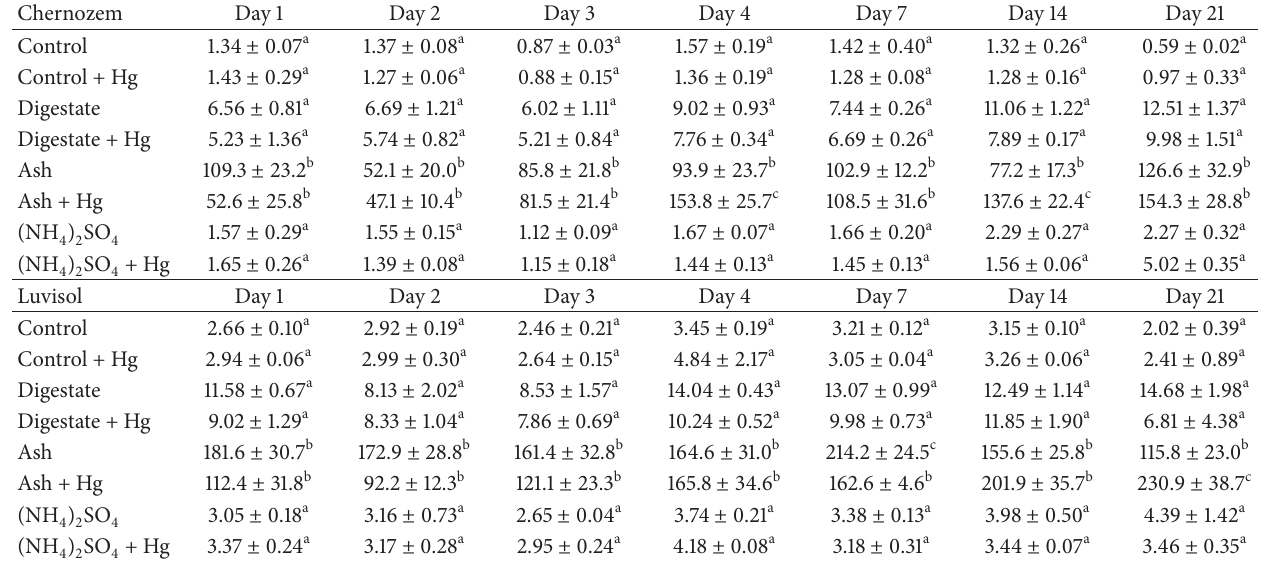
Table 11: The concentrations of Zn extractable with 0.11molL − 1 acetic acid within the incubation experiment (mg ⋅ kg − 1 ); the averages marked by the same letter did not significantly differ at 𝑃 < 0.05 within individual columns; data are presented as mean ± standard deviation ( 𝑛 = 3 ).